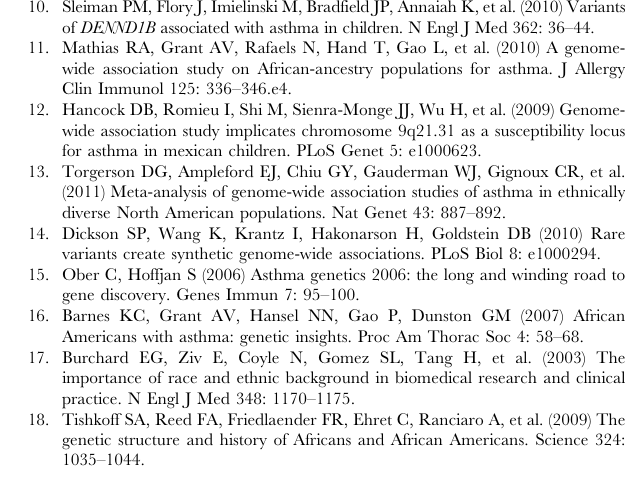
Table S1 Ancestry informative markers used in African American samples from REACH and BASS, and p -values for the association of individual markers with asthma.